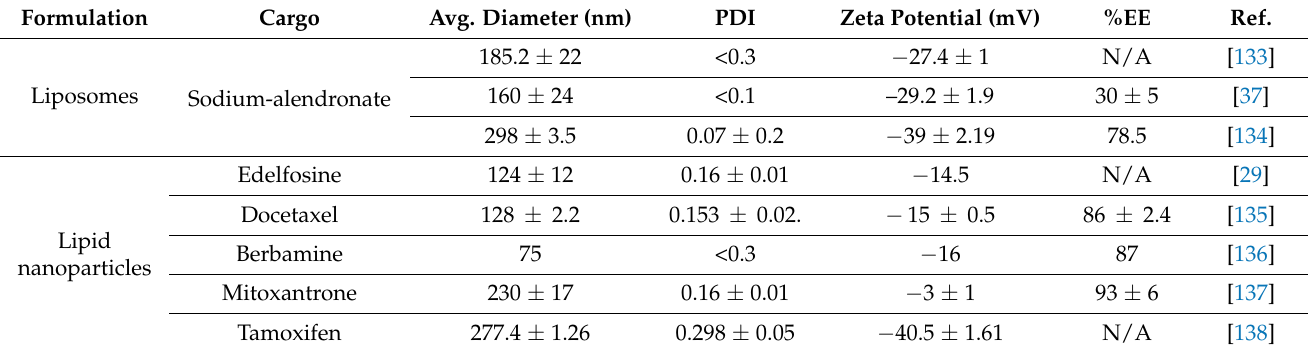
Table 3. Characterization parameters of lipid nanosystem developed for bone